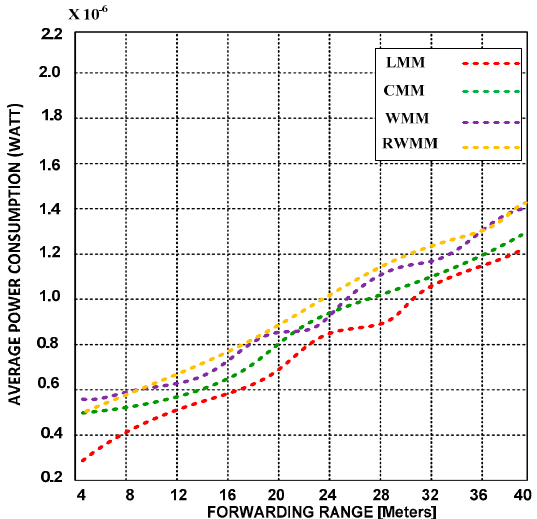
Figure 6. Power consumption versus forwarding range at 25 m event range and 50% mobility rates.